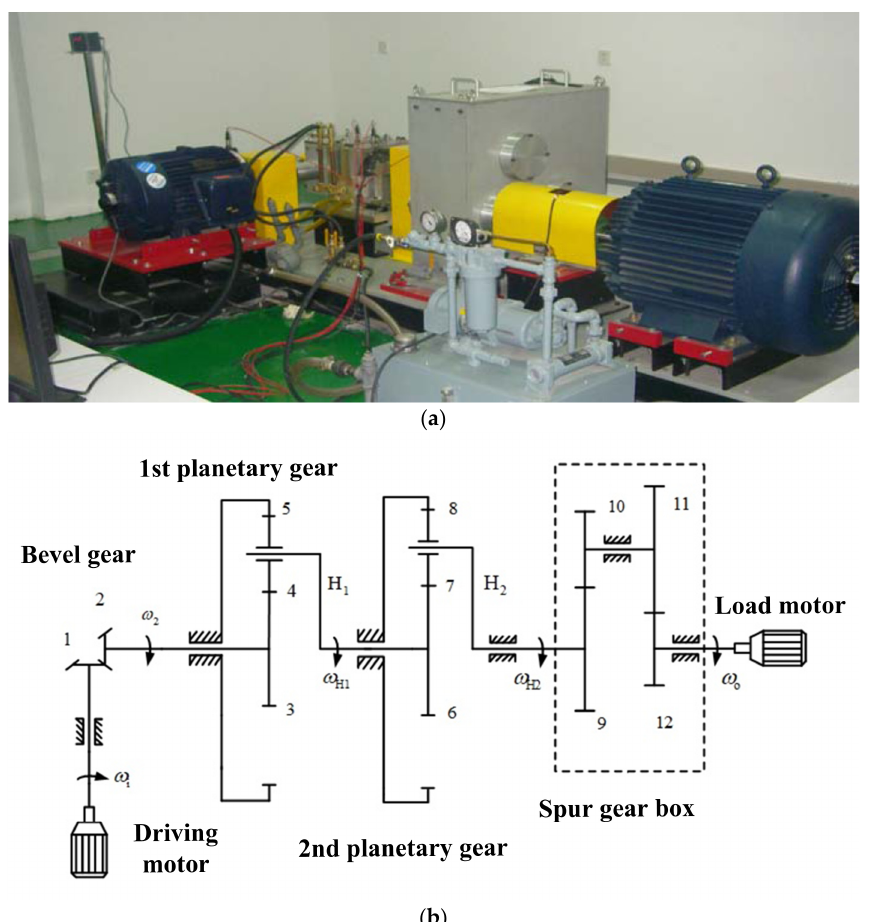
Figure 22. Experimental test rig of the gear transmission system: ( a ) photograph; ( b ) schematic dia-